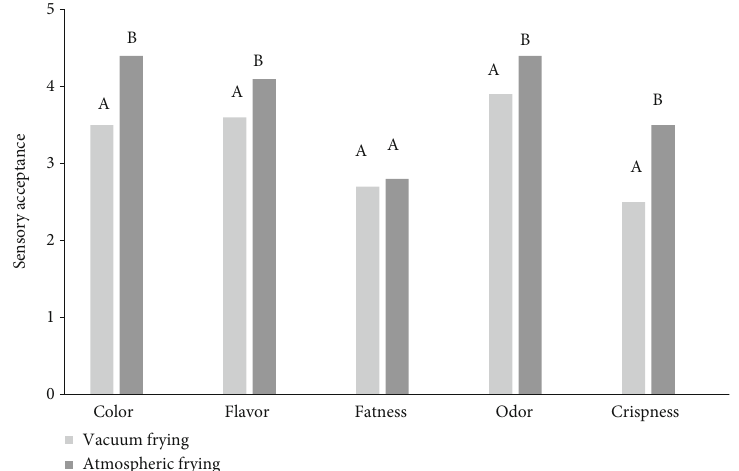
Figure 3: Samples of Colombian coastal Carimañolas fried under vacuum and atmospheric conditions. Means within a bar followed by the same letter are not signi fi cantly di ff erent ( P ≤ 0 : 05